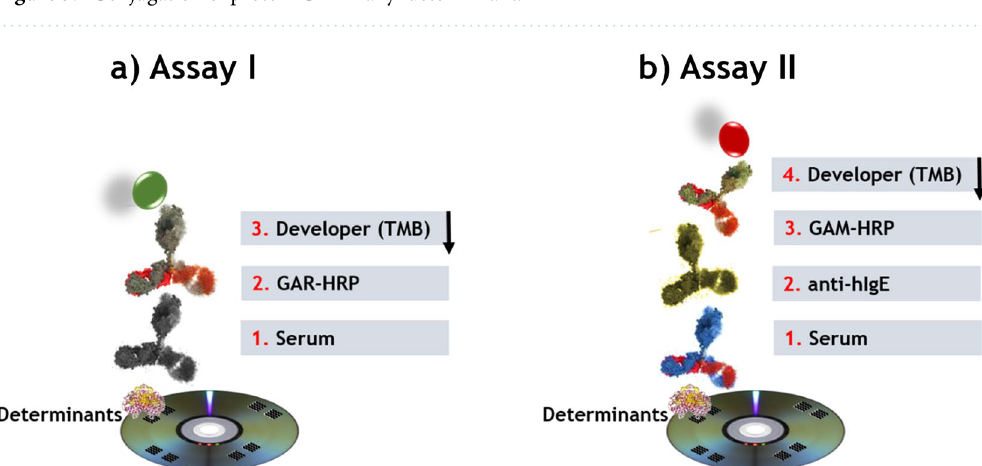
Figure 4. Scheme of the multiplexed microimmunoassays I and II based on a direct format with colorimetric